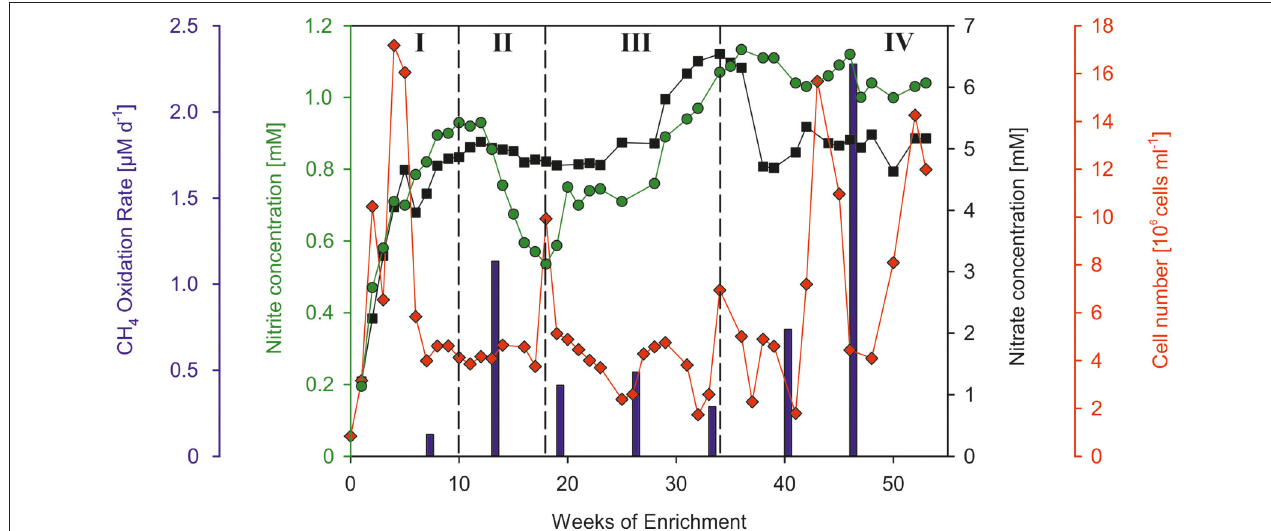
FIGURE 4 | Overview of the temporal development of the cell number (red diamonds), concentrations of nitrate (black squares) and nitrite (green circles), and methane oxidation rates (blue bars). Roman numerals denote the different development stages of the enrichment culture (see